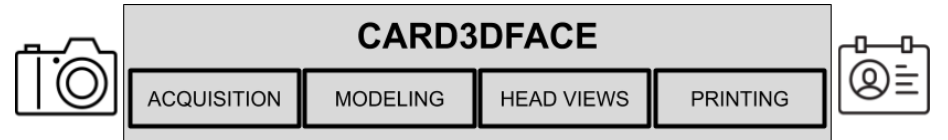
Figure 1. The pipeline of the proposed